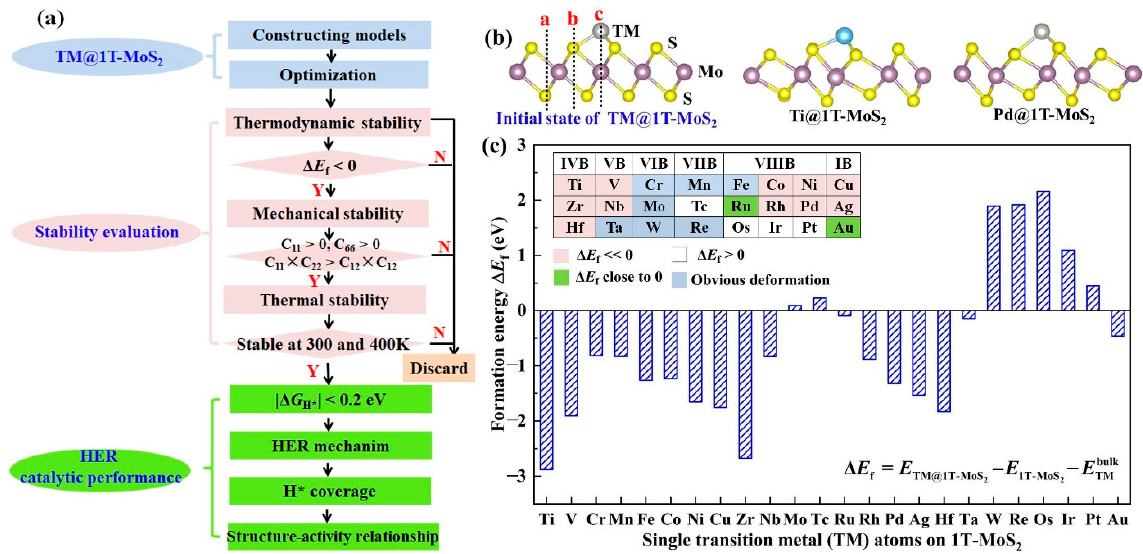
Figure 1. ( a ) Screening procedures of single transition metal (TM) atoms anchored on the monolayer 1T-MoS 2 basal plane (TM@1T-MoS 2 ) as HER electrocatalysts. ( b ) Initial and optimized structure of Ti@1T-MoS 2 and Pd@1T-MoS 2 , where the a, b, c sites represent the possible initial adsorption patterns of single atoms. ( c ) Formation energy of TM@1T-MoS 2 hybrids .